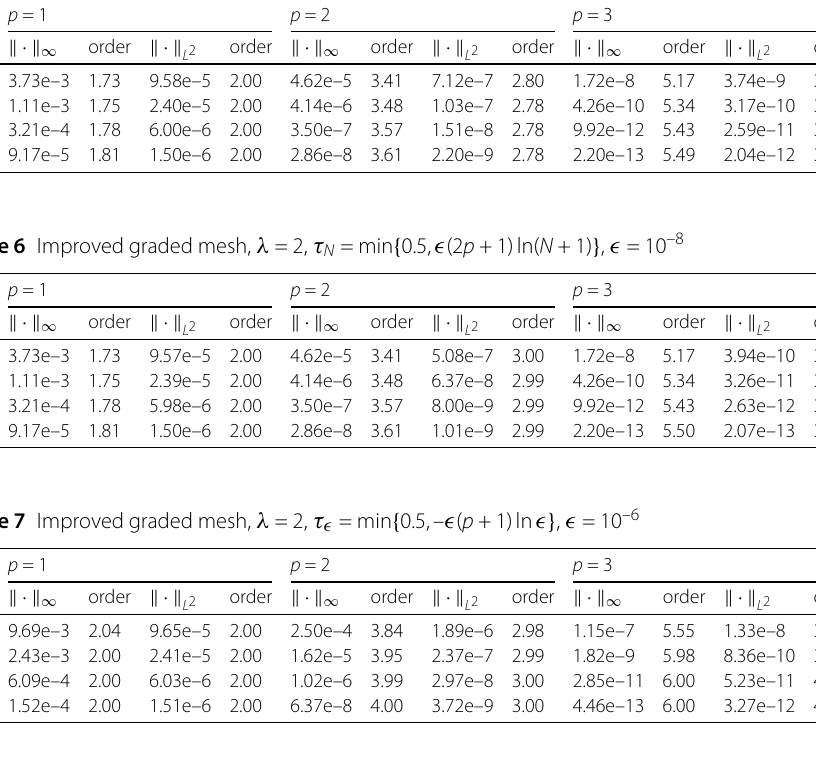
Table 5 Improved graded mesh, λ = 2, τ N = min { 0.5, (cid:2) (2 p + 1)ln( N + 1) } , (cid:2) = 10 –6 N p = 1 p = 2 p = 3